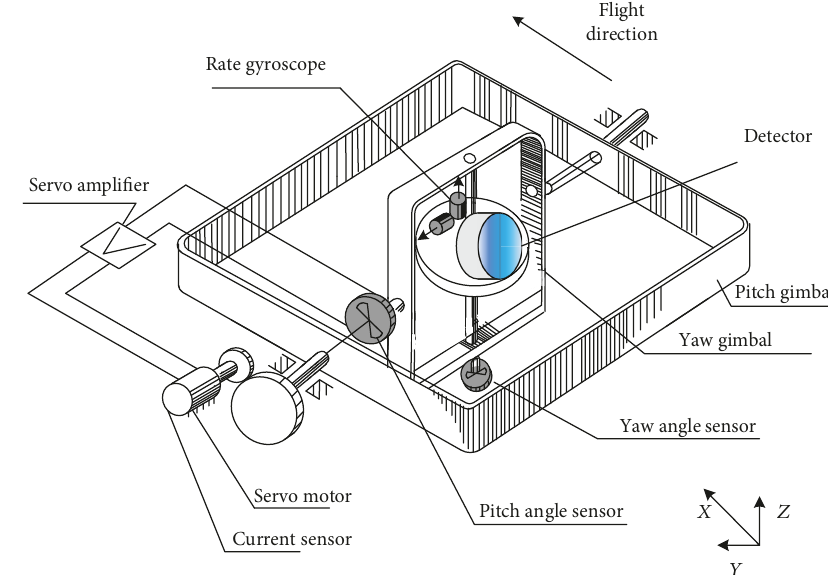
Figure 1: Schematic diagram of the two-axis GSP.